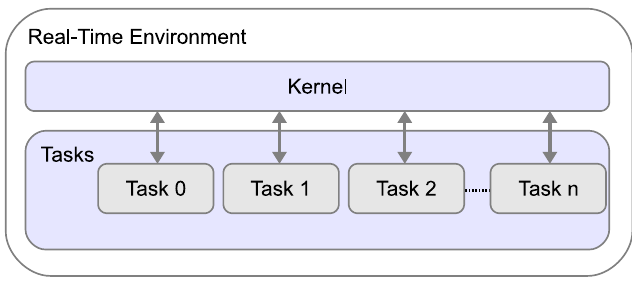
Figure 4. Main classes in the JTT